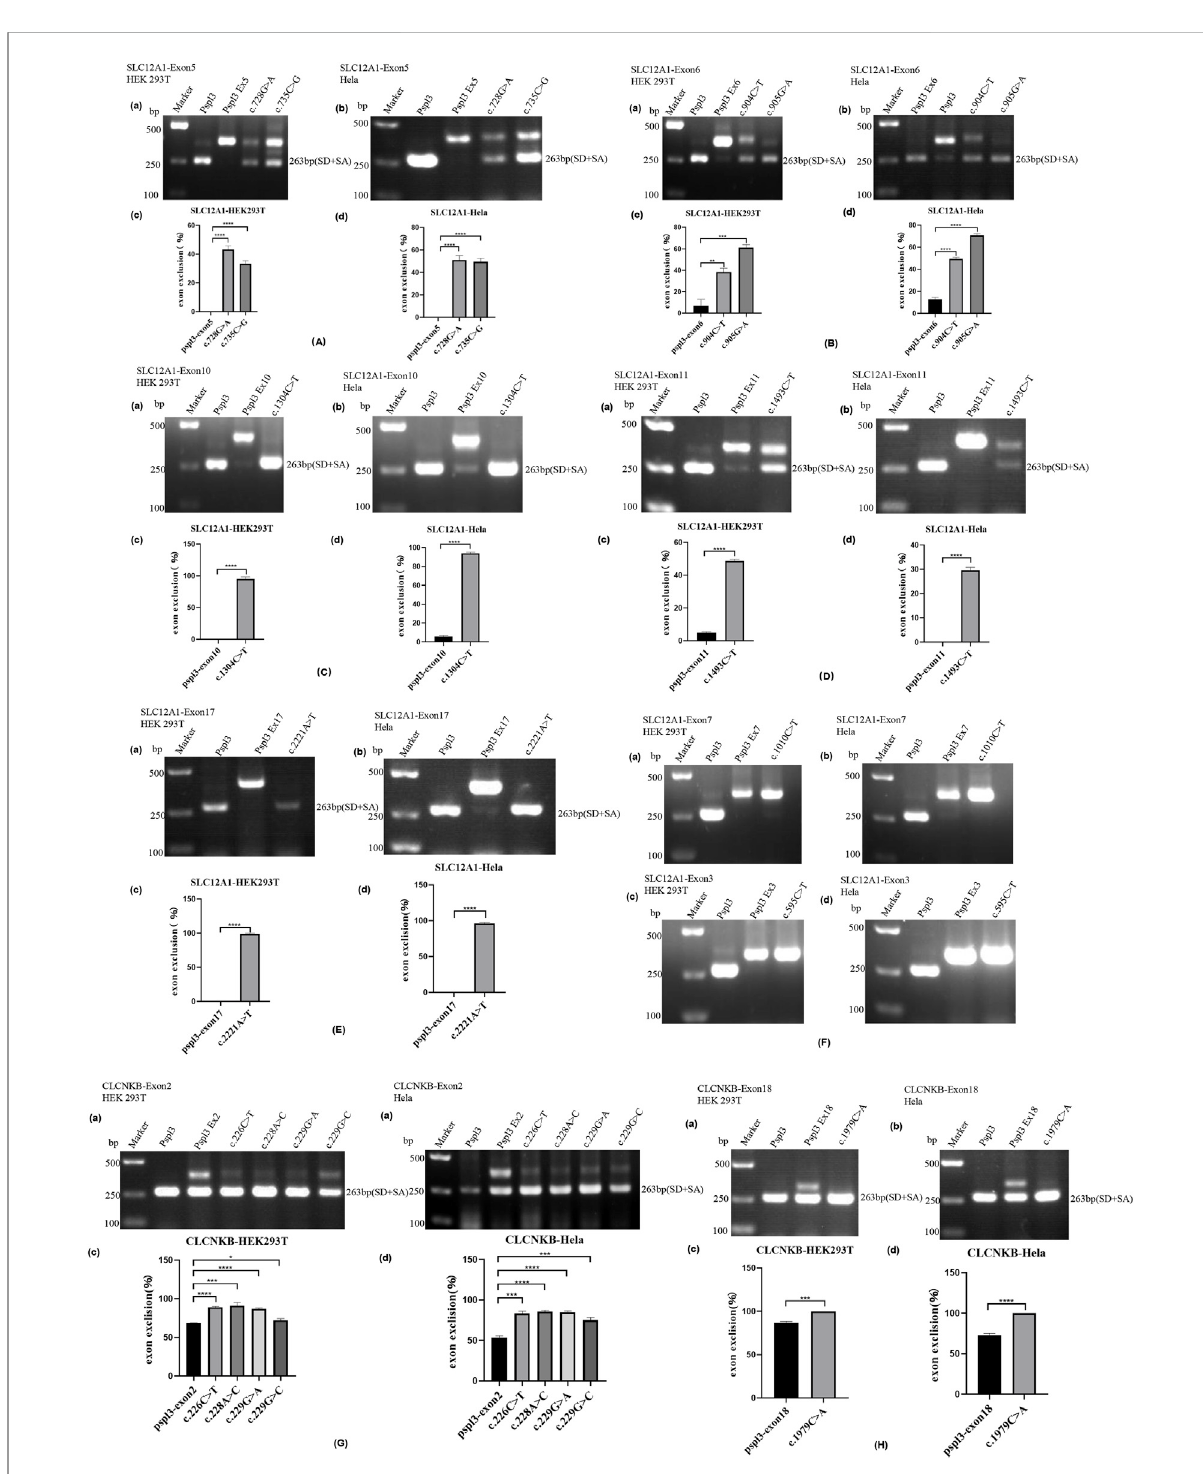
FIGURE 2 Agarose gel electrophoresis and statistical analysis of RT-PCR products in HEK 293T and Hela cells. Quanti fi cation of the splicing percentage was denoted by the percentage of exon exclusion (%) calculated as [lower band/(lower band + upper band)] × 100. Error bars represent SEM (n = 3). *p < 0.05; **p < 0.01; ***p < 0.001; ****p < 0.0001, unpaired Student ’ s t-test. (A) (a,b) Lane 1:marker;lane 2: pSPL3 (263 bp); Lane 3: pSPL3 Ex5 (405 bp); Lane 4: c.728G > A (405bp and 263 bp);Lane 5: c.735C > G(405bp and 263 bp). (B) (a,b) Lane1:marker;lane2: pSPL3 (263 bp); Lane 3: pSPL3 Ex6 (374 bp); Lane 4: c.904C > T (374bp and 263 bp);Lane 5: c.905G > A (374bp and 263 bp). (C) (a,b) Lane1:marker;lane2: pSPL3 (263 bp); Lane 3: pSPL3 Ex10 (415 bp); Lane 4: c.1304C > T (263 bp). (D) (a,b)Lane1:marker;lane2: pSPL3 (263 bp); Lane 3: pSPL3 Ex11 (415 bp); Lane 4: c.1493C >